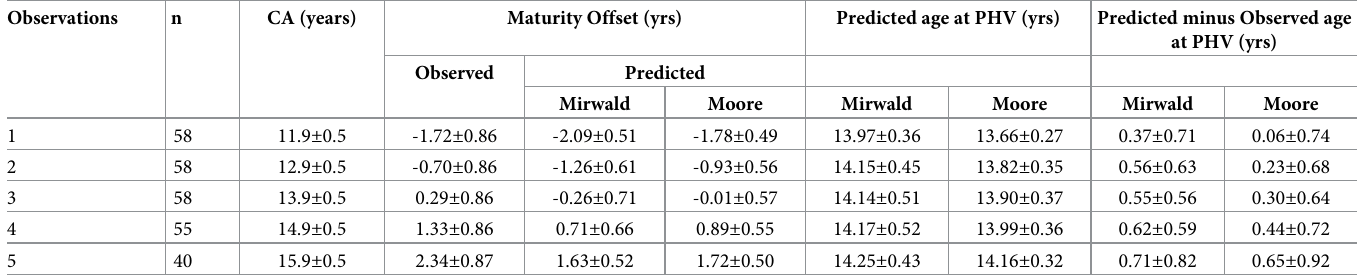
Table 1. Sample sizes and descriptive statistics for chronological age (CA) at prediction, observed maturity offset and predicted maturity offset and ages at PHV, and the difference of predicted age at PHV minus observed ages at PHV (criterion) with the original (Mirwald) and modified (Moore) equations in soccer players at each observation†. Observations